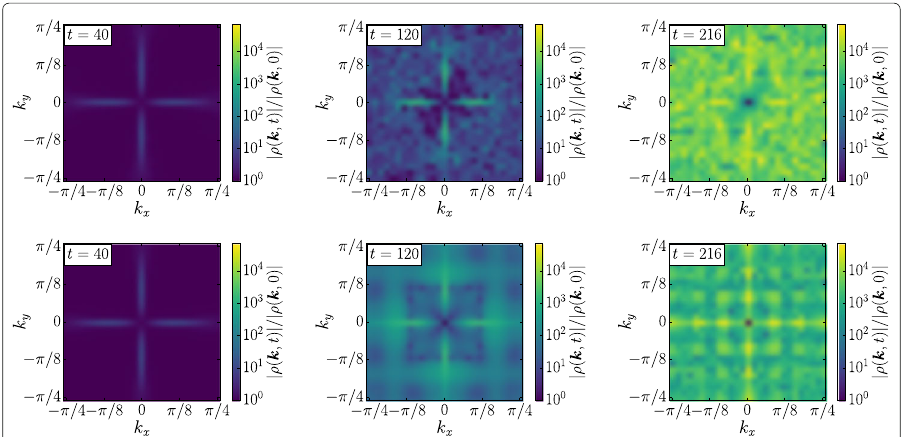
Fig. 2 Time evolution of Fourier patterns ρ( k , t ) ; top: patterns growing from uncorrelated Gaussian noise (initial condition (i)), bottom: patterns growing from a single localized perturbation (initial condition (ii)); parameters as in Fig.